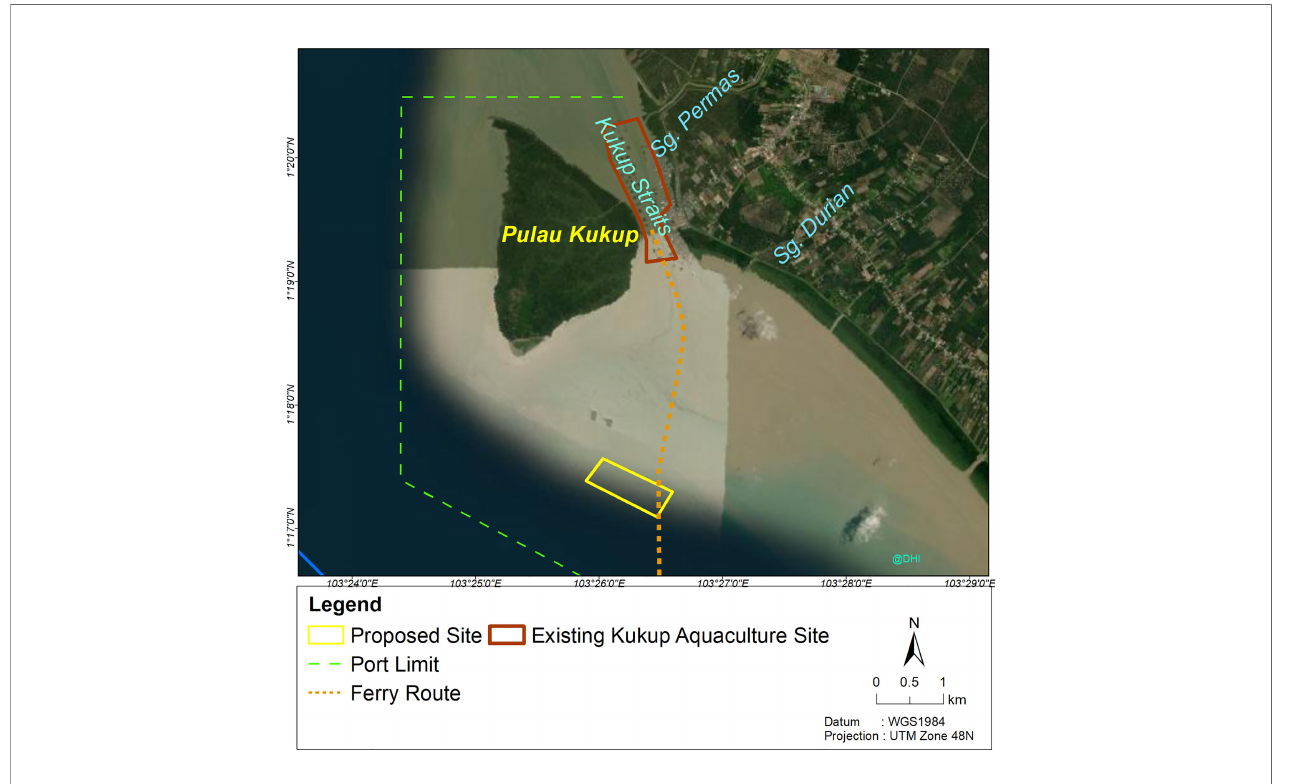
FIGURE 1 | Satellite image of existing Kukup aquaculture site and new proposed site.